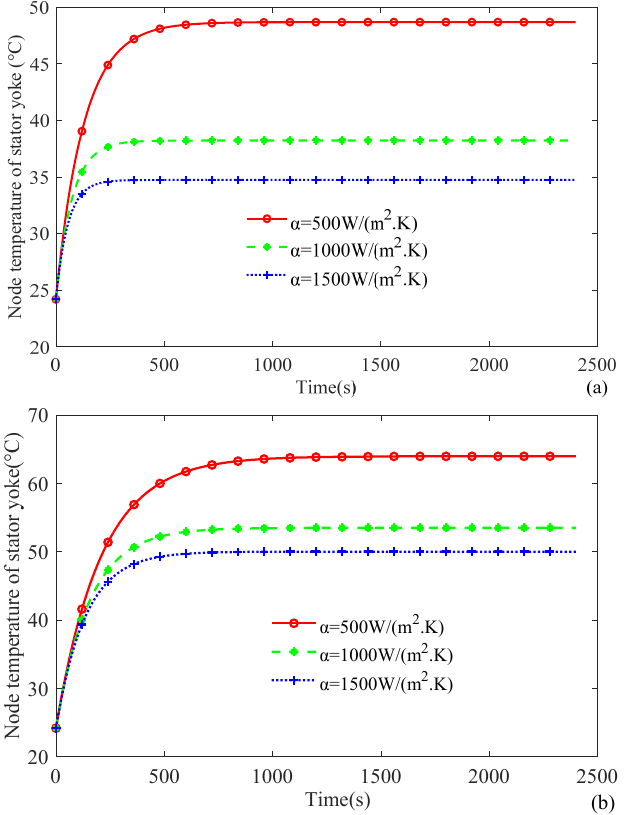
Figure 5. Transient temperature curve of stator yoke iron for different α . ( a ) Direct cooling condition, ( b ) indirect cooling.